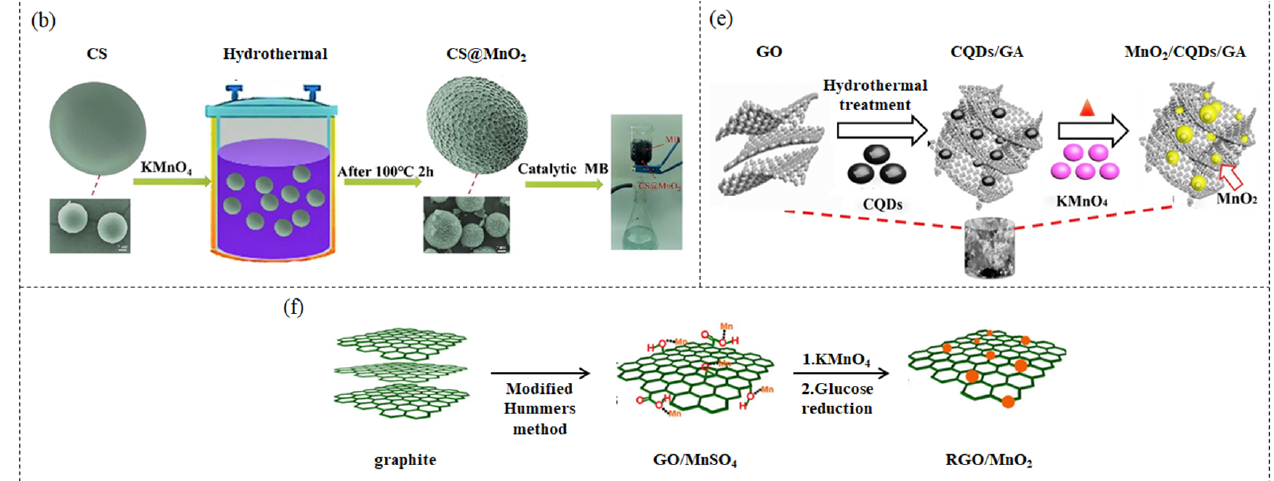
Figure 1. ( a ) Schematic illustration of the preparation of MnO 2 − RGO nanocomposite. Figures re-